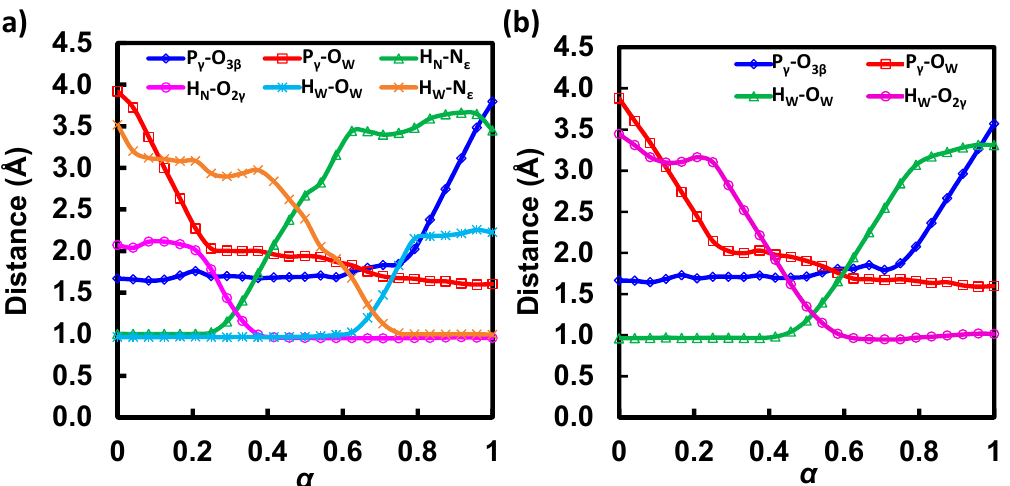
Figure 4. Progressions of collect variables along the MFEPs for ( a ) the GAC and ( b ) the SAC mechanisms in ATP hydrolysis catalyzed by HlyB-NBDs obtained at the AM1/CHARMM22 level. Under the SAC mechanism, the overall free energy of ATP hydrolysis in the HlyB-NBD active site is − 12.2 kcal/mol; this exergonicity is much closer to the unperturbed chemical equilibrium for